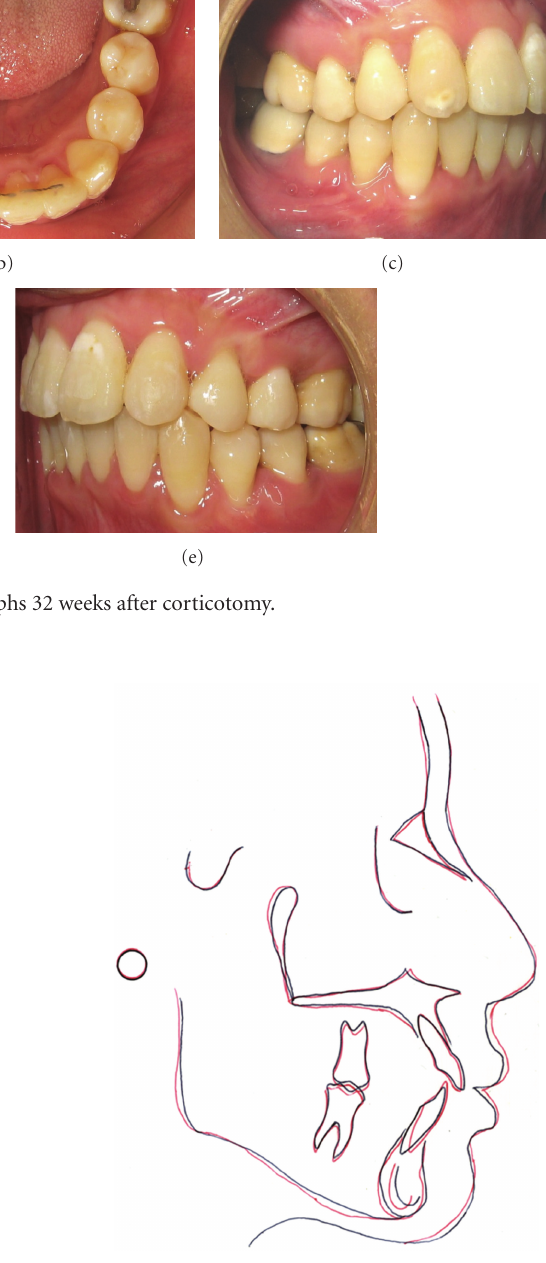
Figure 11: Cephalometric superimposition (pretreatment: black and posttreatment: